Question: How would you classify this visualization?
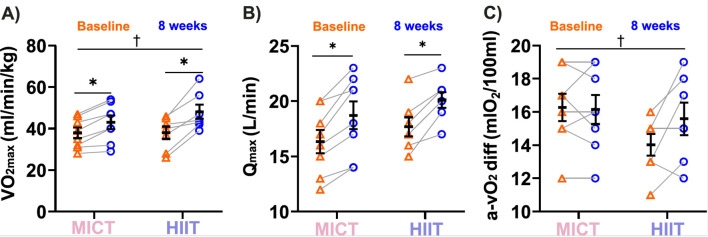
Answer: line